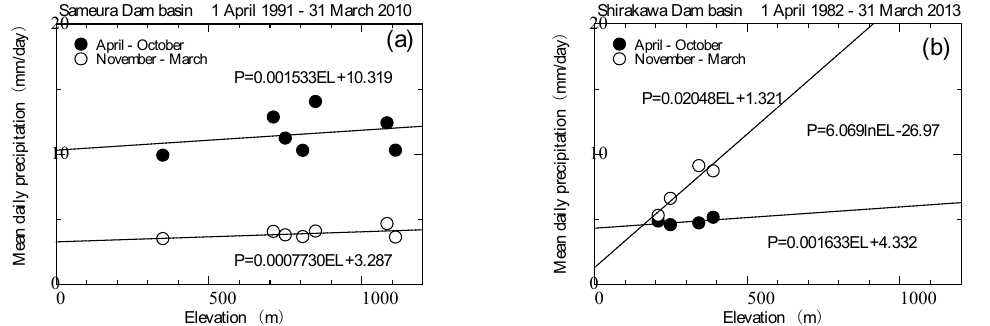
Fig. 2 Seasonal relationship between mean daily precipitation and elevation for the SAME basin (a) and for the SIRA basin